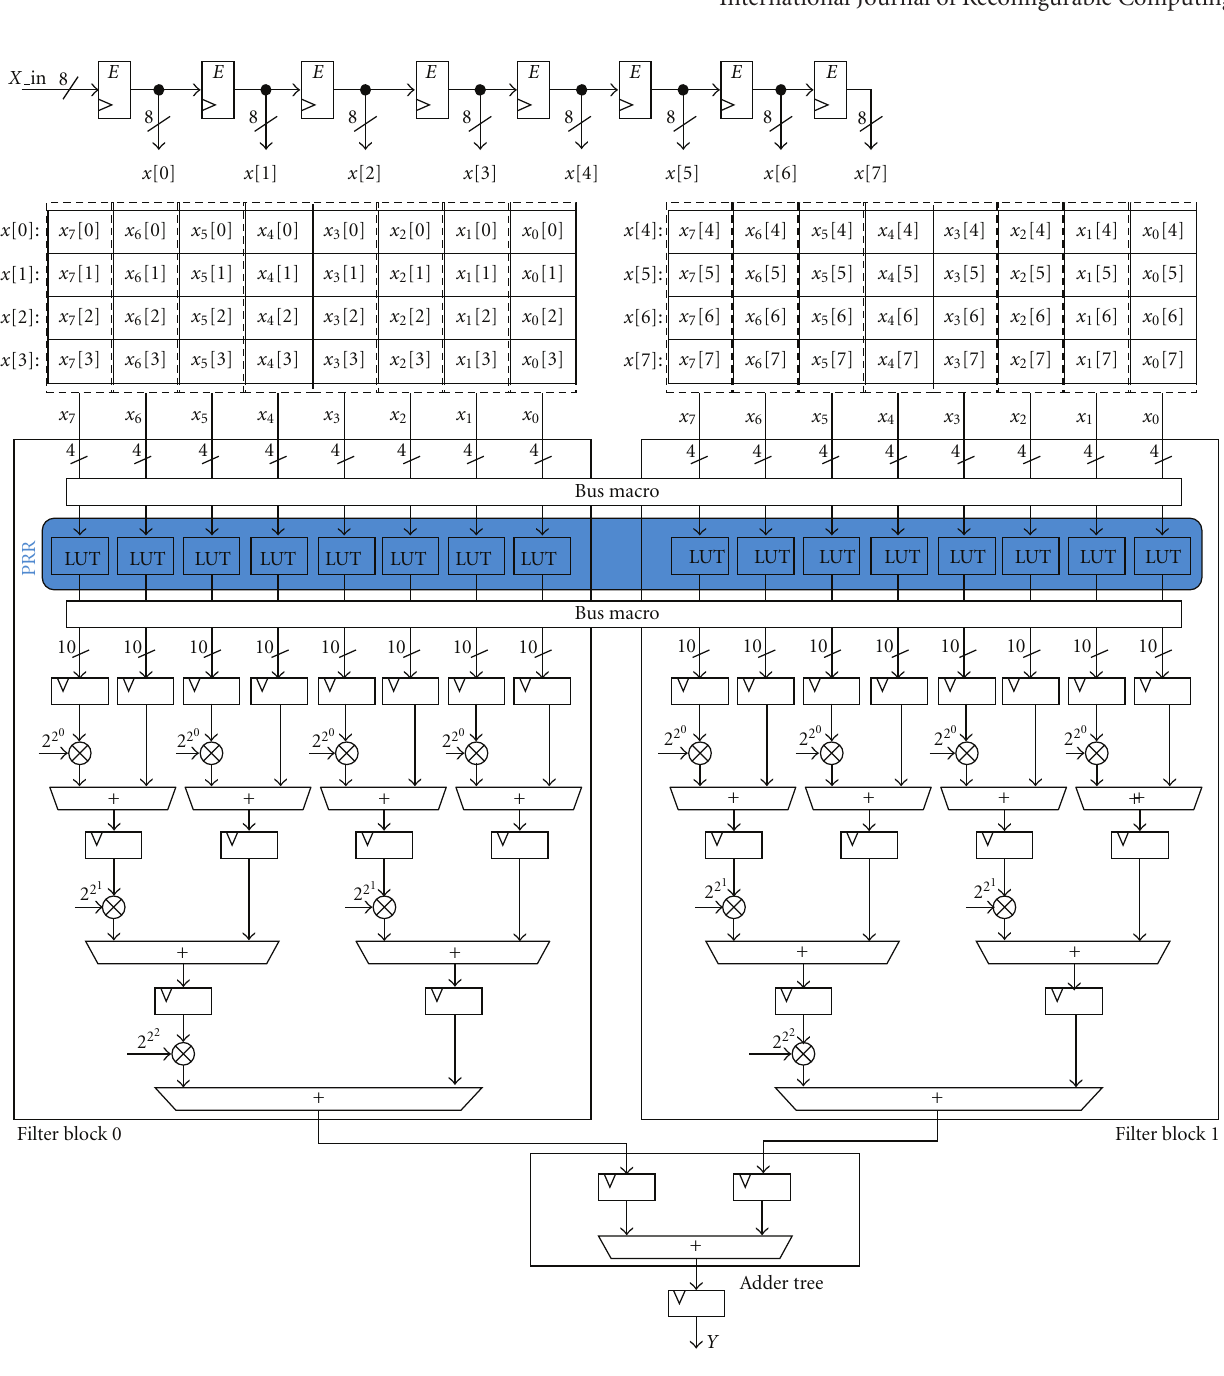
Figure 9: FIR filter core where the PRR and bus macros can be appreciated. Here, we can modify only the coe ffi cients via the LUTs.